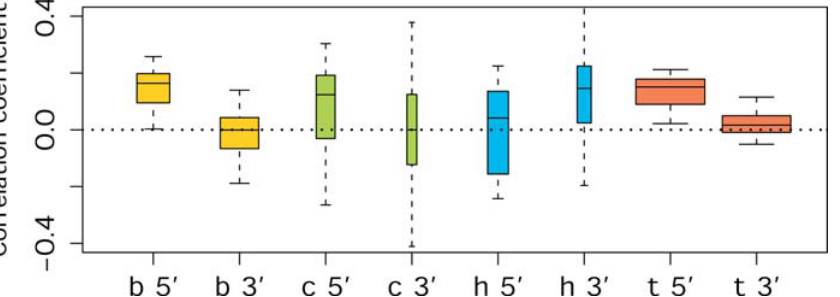
Figure 6. Correlation between Signal Intensity Difference of Intergenic Probes and that of the Nearest Exon Letters and colors indicate tissues (B, yellow—brain; C, green—cell line; H, blue—heart; T, red—testis). Correlation was calculated separately for probes located upstream (5 9 ) or downstream (3 9 ) from the nearest exon. The width of the bars is proportional to the number of the ENCODE regions showing significant correlations (Spearman correlation test, p , 0.05, corrected for multiple testing). The mean of the bars shows the mean correlation coefficient, while the bar borders represent a 75% confidence interval. The error bars depict a 95% confidence interval of the correlation coefficient, calculated by bootstrapping the list of intergenic probes within each region 500 times (Materials and Methods). DOI: 10.1371/journal.pgen.0020171.g006 PLoS Genetics |